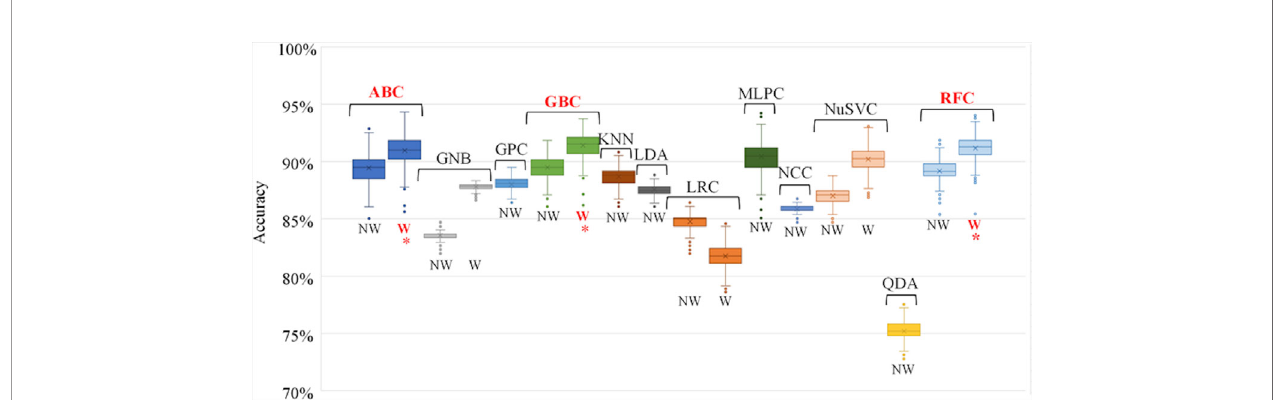
FIGURE 4 | Individual model accuracy over 100 random training/testing iterations. For classi fi cation algorithms compatible with using weighted samples, both weighted and unweighted tests were performed. Final selected individual models are indicated with an *. NW, No Weight, W, Weighted, ABC, AdaBoost Classi fi er, GNB, Gaussian Naïve Bayes Classi fi er, GPC, Gaussian Process Classi fi er, GBC, Gradient Boosting Classi fi er, KNN, K-Nearest Neighbours Classi fi er, LDA, Linear Discriminant Analysis, LRC, Logistic Regression Classi fi er, MLPC, Multi-layer Perceptron Classi fi er, NCC, Nearest Centroid Classi fi er, NuSVC, Nu-Support Vector Classi fi er, QDA, Quadratic Discriminant Analysis, RFC, Random Forest Classi fi